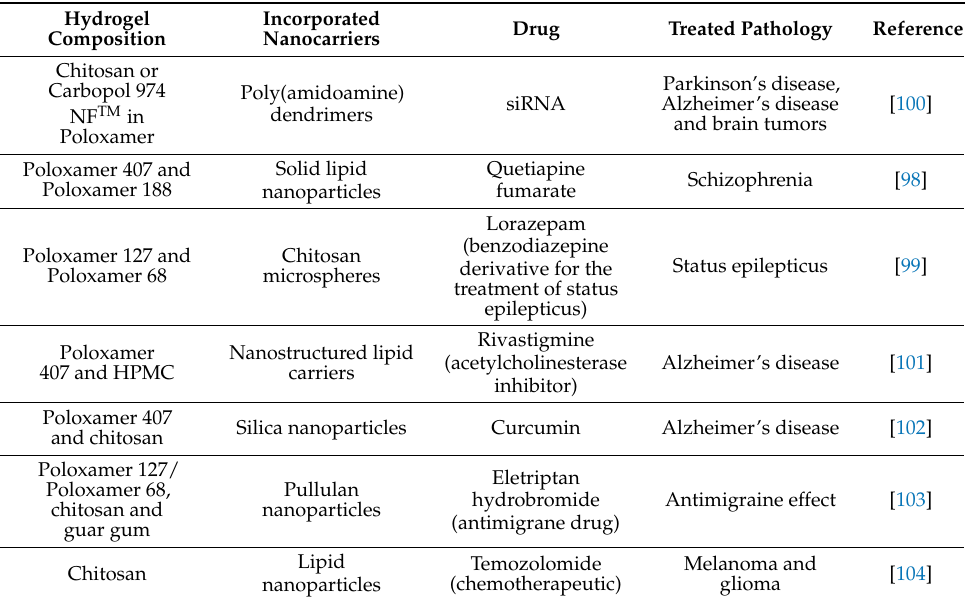
Table 4. Exemplary nanoparticle-loaded hydrogel formulations investigated for IN drug delivery to reach the